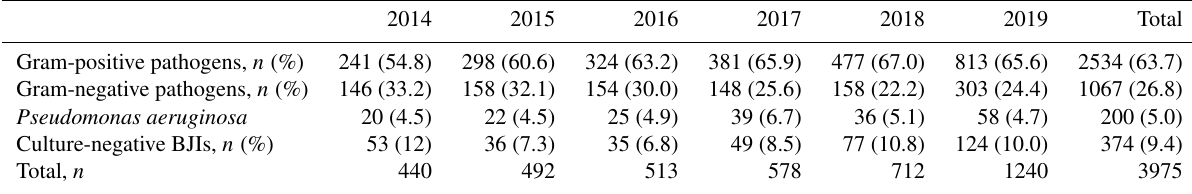
Table 2. Type of pathogens. BJIs – bone and joint